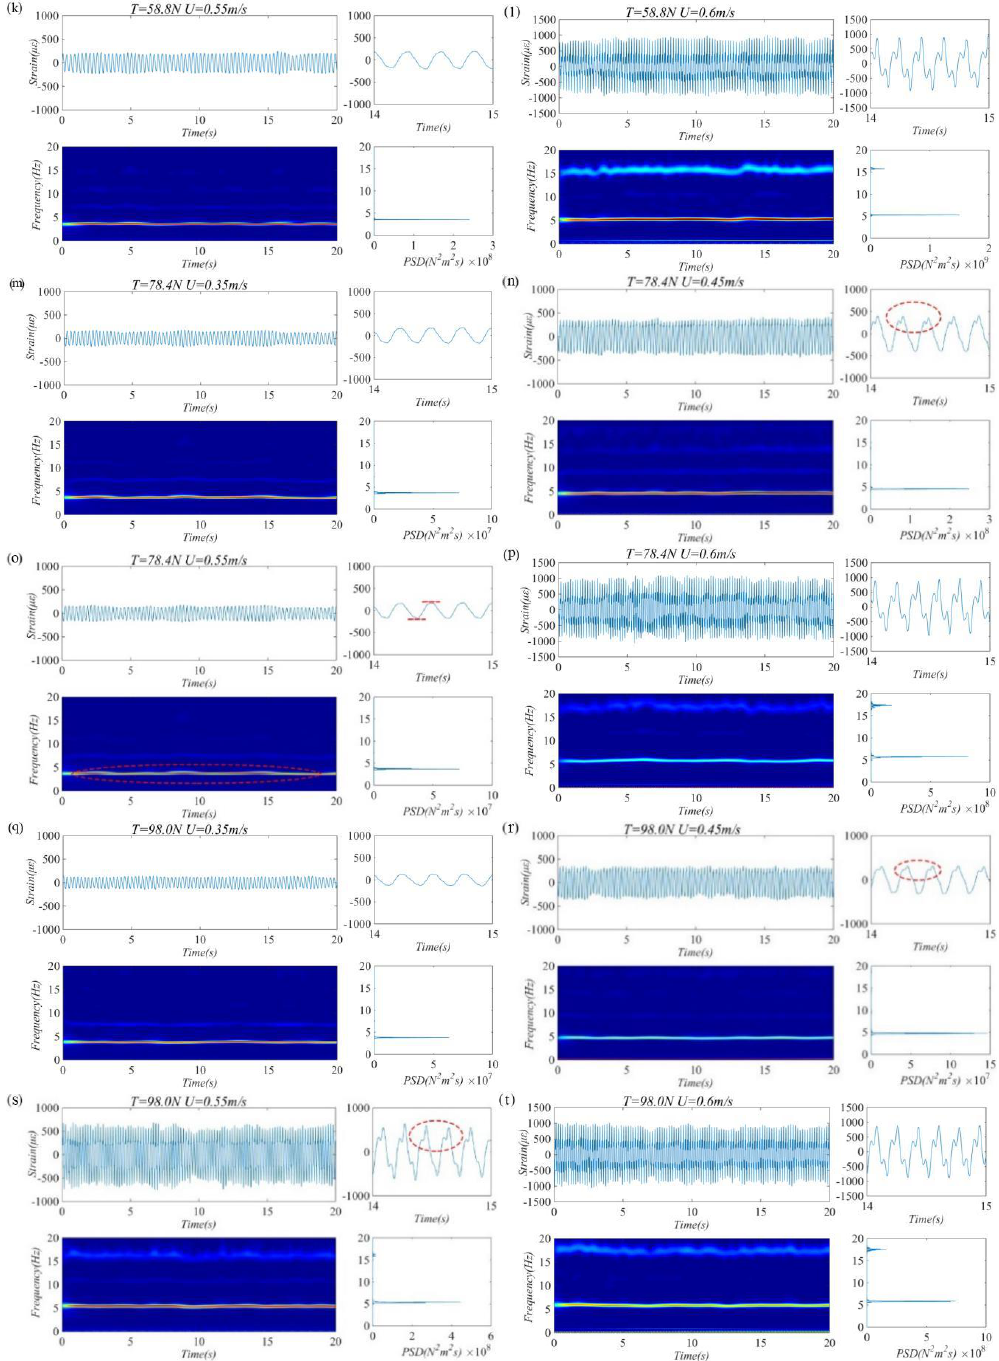
Figure 8. Strain time history (top left), enlargements of strain time history (top right), wavelet time–frequency scale diagrams (bottom left) and power spectral density diagrams (bottom right) of cross-flow riser VIV versus flow velocity under different top tensions (for each level of top tension, ( a )–( d ), ( e )–( h ), ( i )–( l ), ( m )–( p ), ( q )–( t ), correspond to four flow velocities: 0.35, 0.45, 0.55, and 0.6 m /